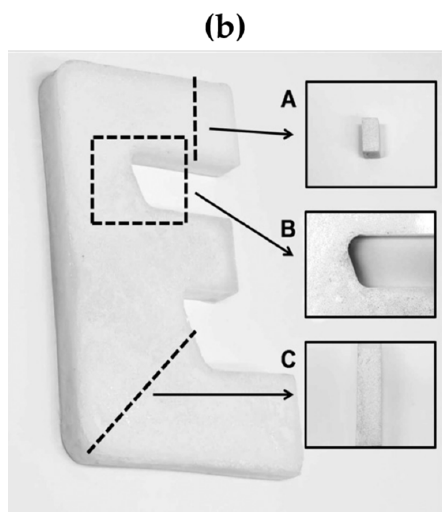
Figure 3. ( a ) Experimental setup for microwave expanding of epoxy-EPS syntactic foam: ( A ) mixing epoxy base and the first-part hardener, ( B ) pre-curing, ( C ) mixing unexpanded EPS microspheres, the second-part hardener, and the procured epoxy, ( D ) transferring foaming feed to a polypropylene mold, ( E ) microwave heating, and ( F ) post-curing]; ( b ) EPS–epoxy syntactic foamed letter “E” part molded via microwave expanding process: ( A ) cross-section of the upper arm, ( B ) magnified image of the upper curving section, and ( C ) cross-section of lower curving section. Reprinted with permission from the authors of [70]. Copyright © (2015) Society of Plastic Engineers.